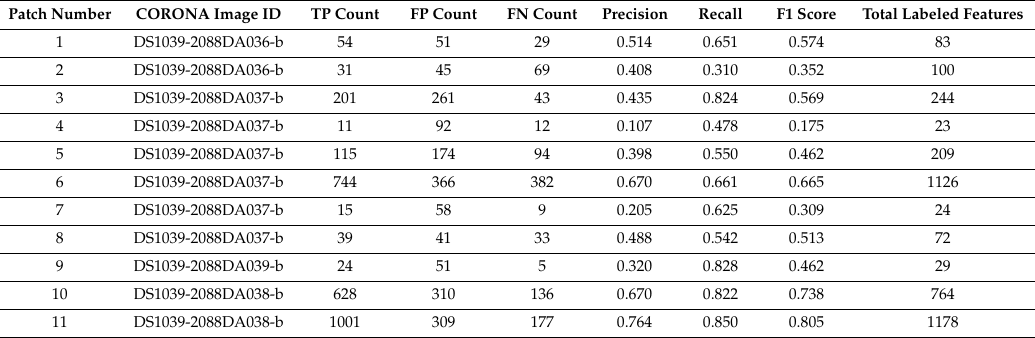
Table 1. Location of the 11 patches used for model training on four strips of the CORONA